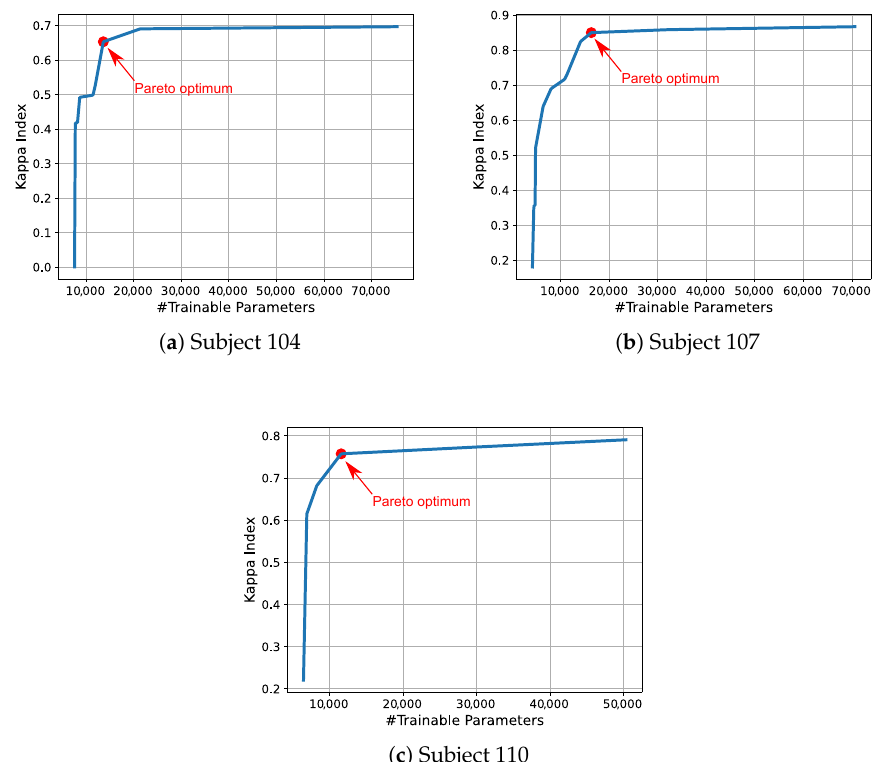
Figure 7. Pareto front corresponding to the neural network optimization process for different